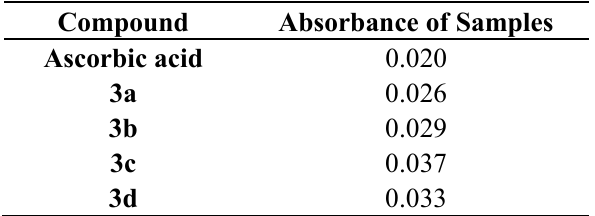
Table 4. Assays for bleomycin-dependent DNA damage.